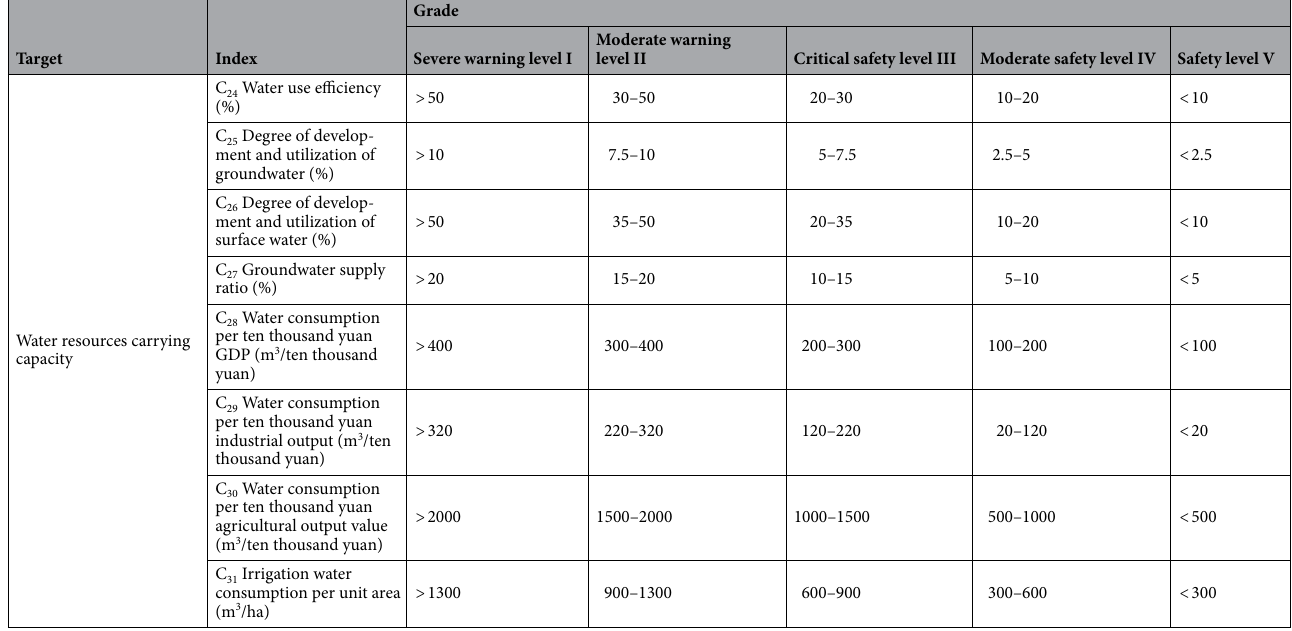
Table 3. Grade classification of water resource security in the karst